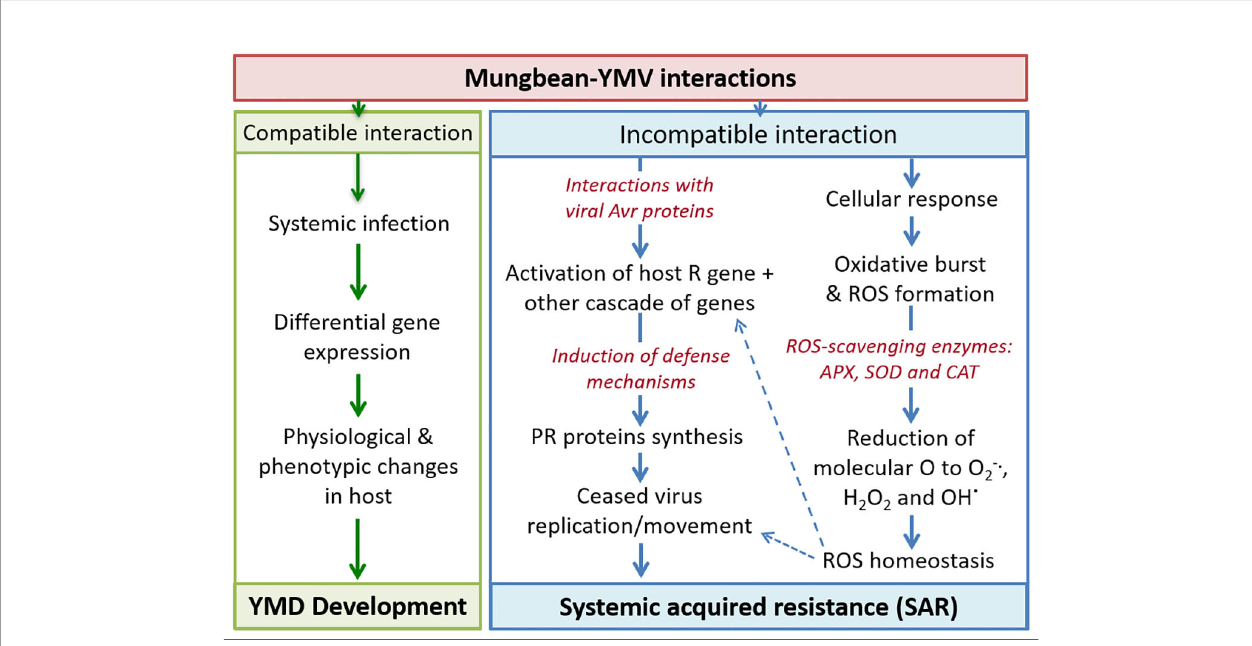
FIGURE 5 | Schematic presentation of plant-virus interaction leading to disease development and resistance expression in mungbean. Where, Avr, Avirulence; R, Resistance; PR, Pathogenesis-Related; ROS, Reactive Oxygen Species; APX, Ascorbate peroxidases; SOD, Superoxide dismutases; CAT,